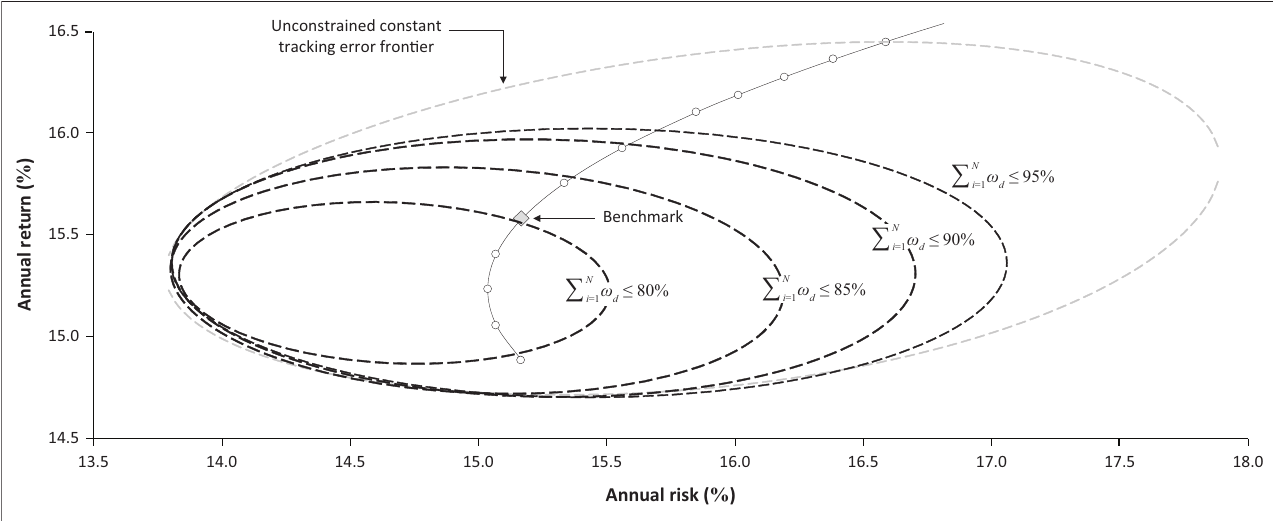
FIGURE 3: Unconstrained (long and short positions permissible) constant tracking error frontier for TE = 5 % and the sum of domestic weights ∑ and 80 %